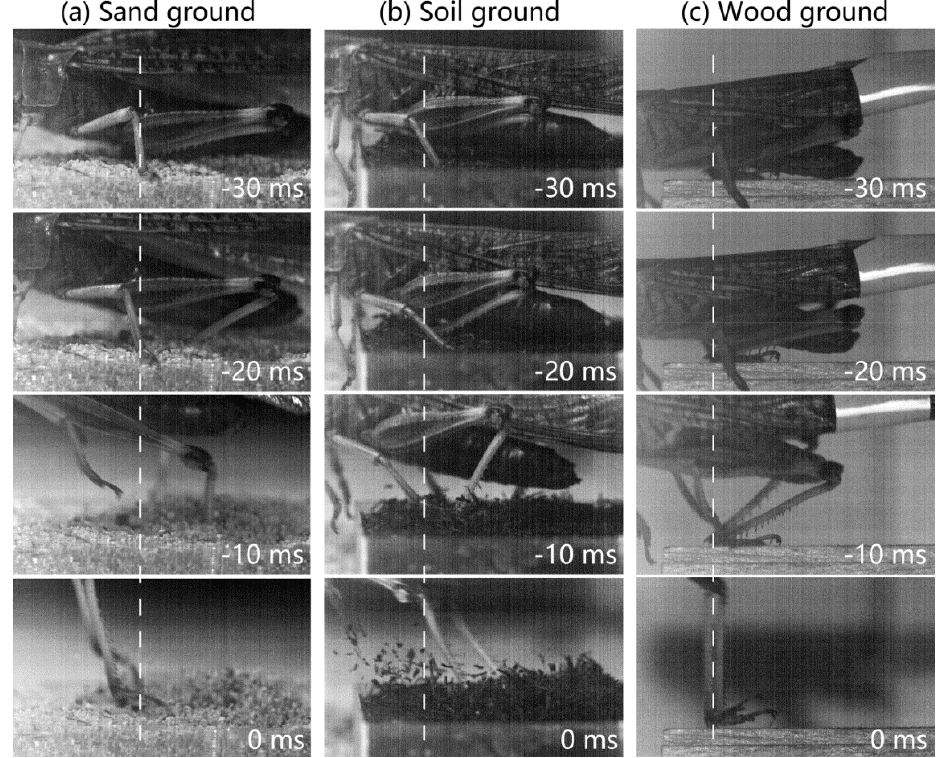
the mass-specific reaction force (